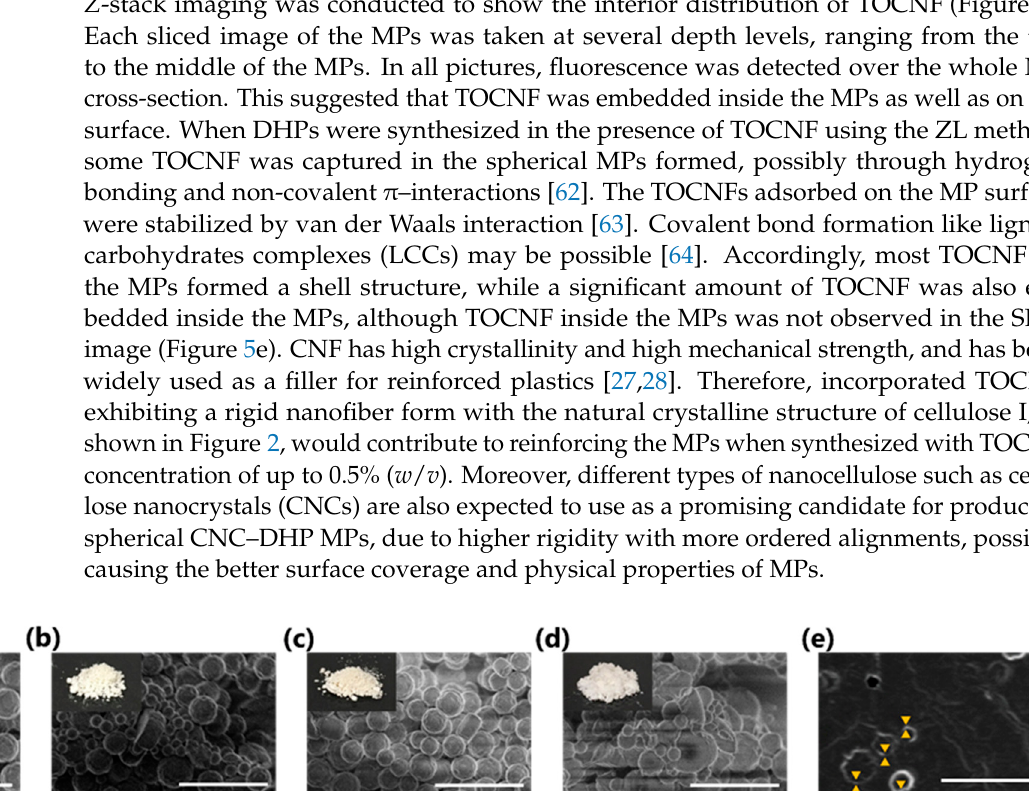
Table 1. Diameter, sphericity index, and ζ -potential of TOCNF–DHP MPs. TOCNF Concentra-